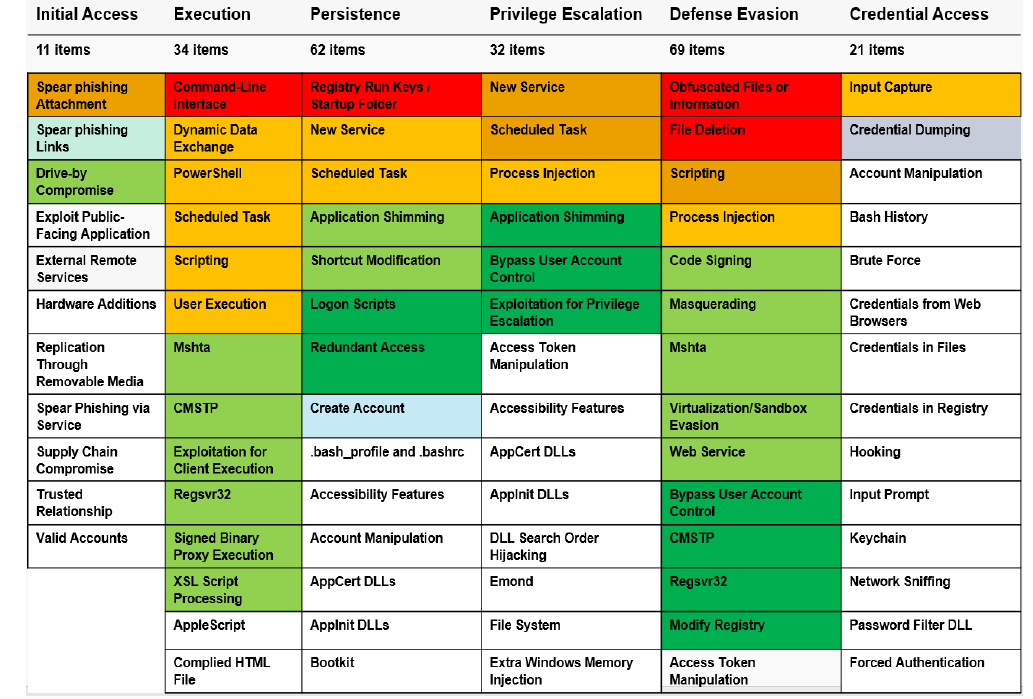
Figure 9. MITRE ATT&CK Framework.